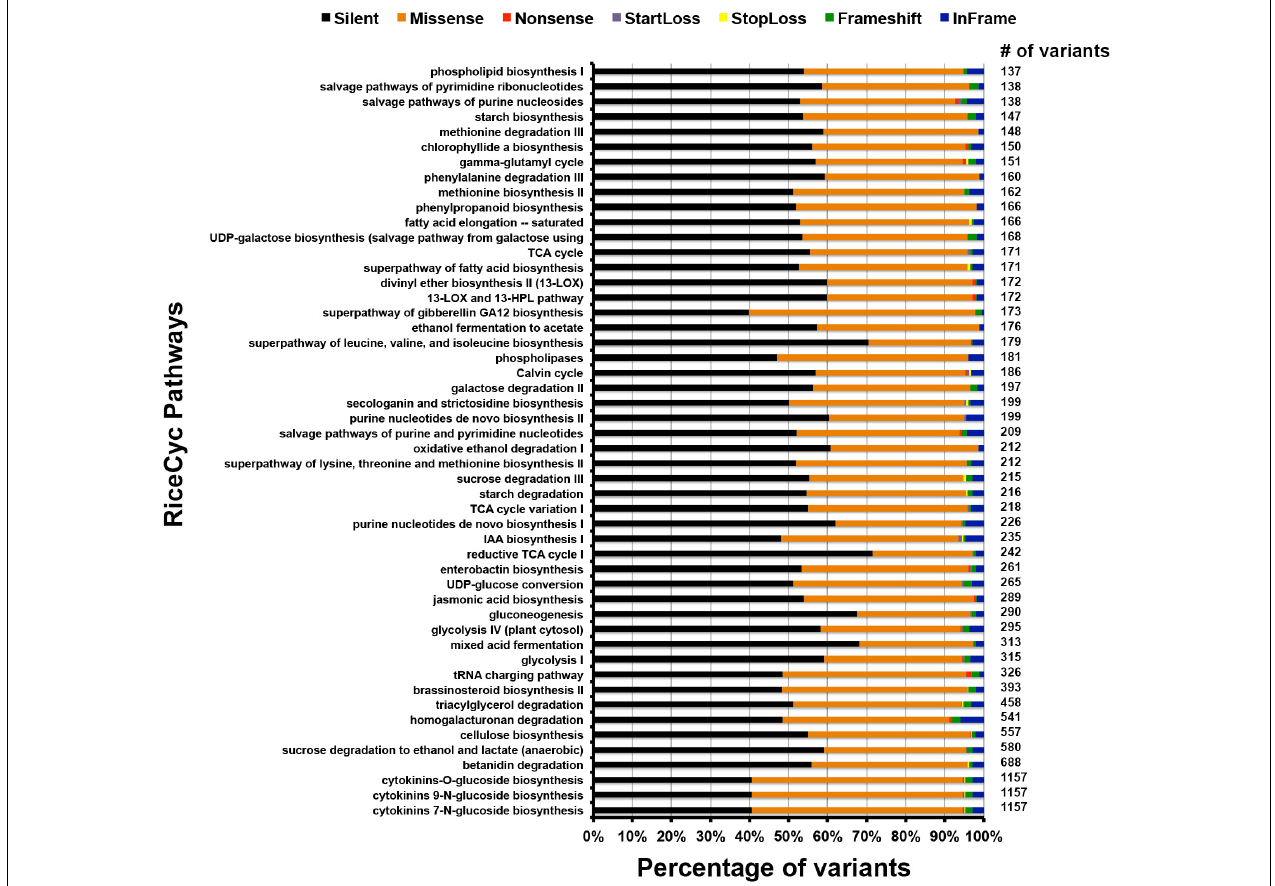
FIGURE 4 | Bar diagram showing total number of different variants and their association in various metabolic pathways.